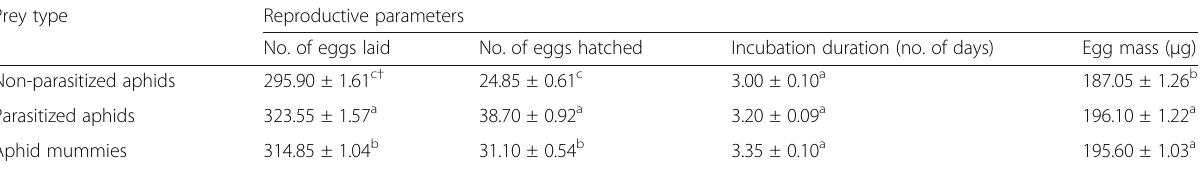
Table 2 Effect of feeding on parasitized, non-parasitized, and mummified aphids on the C. septempunctata reproductive parameters (mean ±